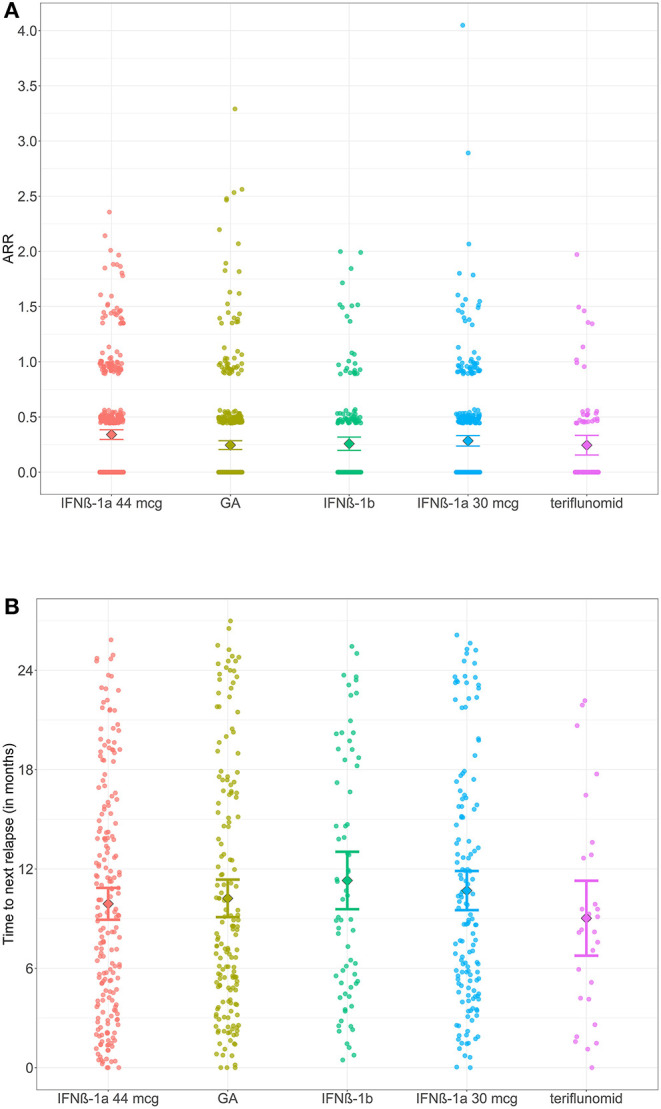
The distribution of times to next relapse and ARR and the 95% confidence interval estimates of means for the DMD groups. Data points (circles) show all values of (A) time to next relapse, (B) ARR. The rhombus represents the group mean, and error bars depict 95% confidence interval estimates of means for the DMD groups.